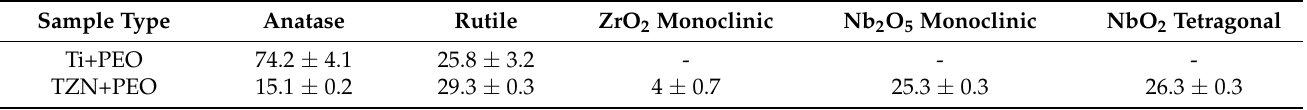
Table 3. Estimation of the crystalline phase content (wt %) of the PEO coatings from the XRD analysis. Sample